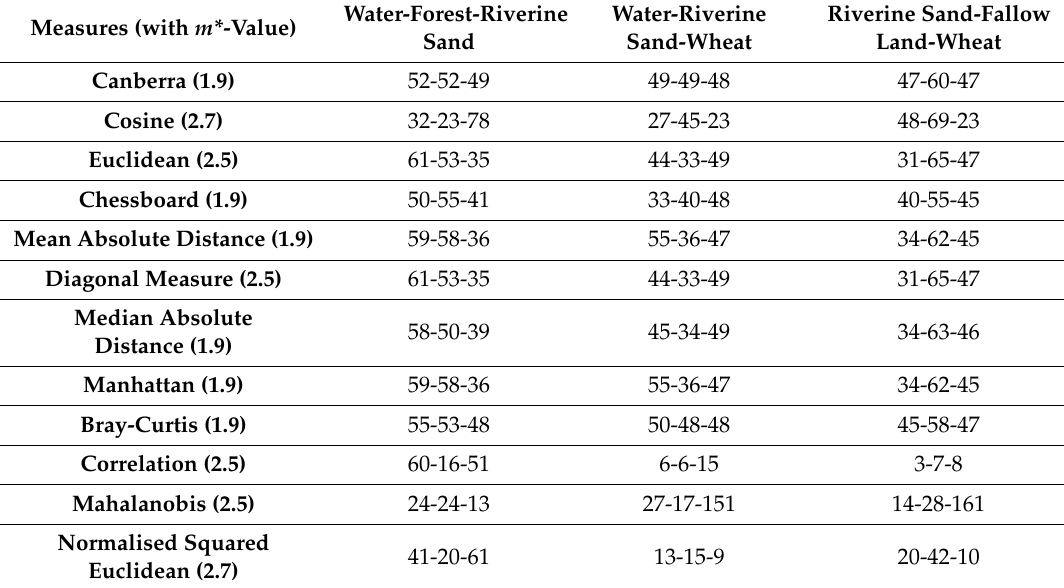
Table 4. Shows the results of all the measures while handling the mixed pixel containing three classes (membership value was calculated on 8-bit scale i.e., the target values for each class were 76.5, 76.5 and 102,